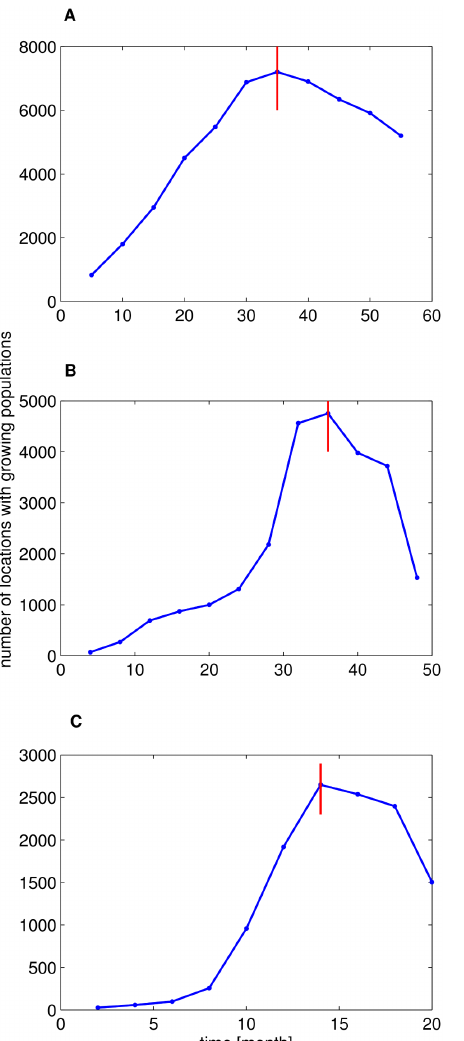
Figure 6. Selection method for t 0 . The number of locations with growing populations ( S ( t 1 ) w S ( t 0 ) ) as a function of time. We account for the tradeoff between a large number of populated locations and a large time series length t 1 { t 0 by choosing t 0 close to the maximum, cf. Methods. This results (a) for Renren to t 0 : ~ 35 , (b) for Twitter to t 0 : ~ 36 , and (c) for Gowalla to t 0 : ~ 14 .